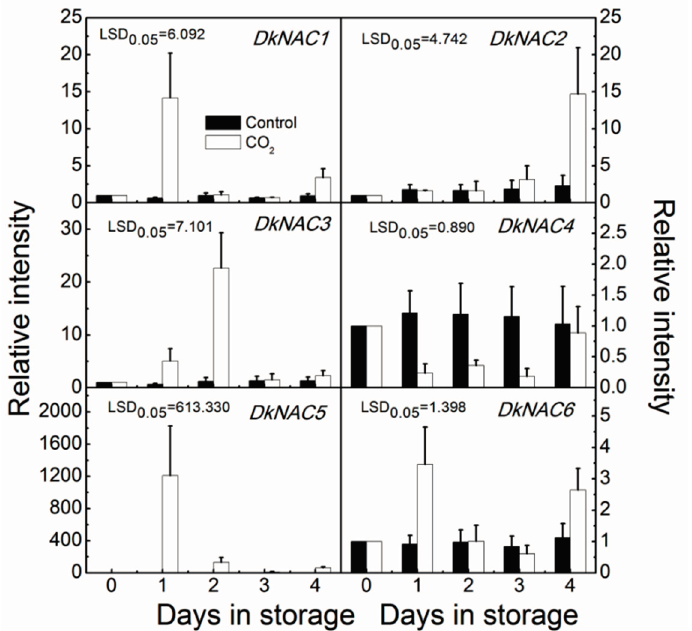
Figure 6. Transcriptional analysis of DkNAC genes. Transcripts of DkNAC genes were measured by real-time PCR. Fruit were treated with 95% CO 2 for one day at 20 °C in sealed container, while control fruit was sealed in a similar container without any treatment. Day 0 fruit values were set as 1. Error bars indicate standard error from three biological